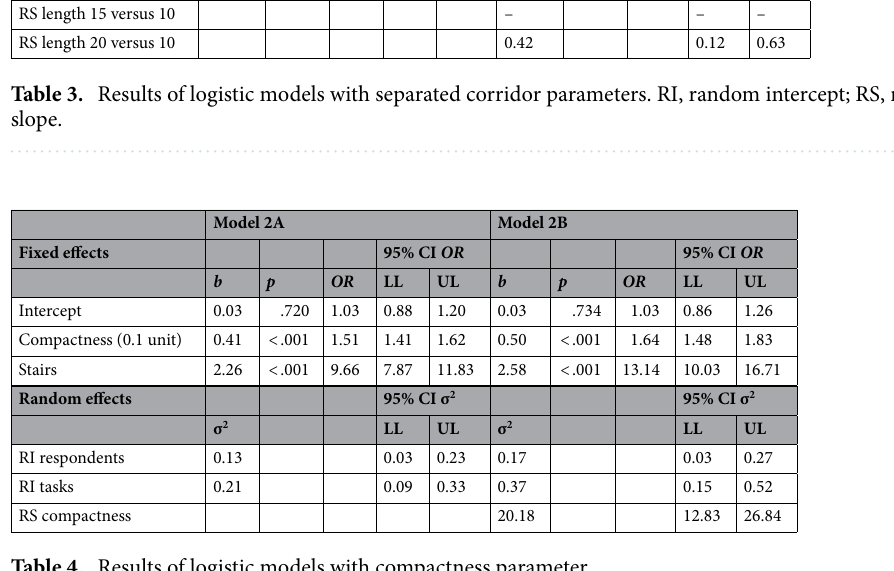
Table 4. Results of logistic models with compactness parameter.